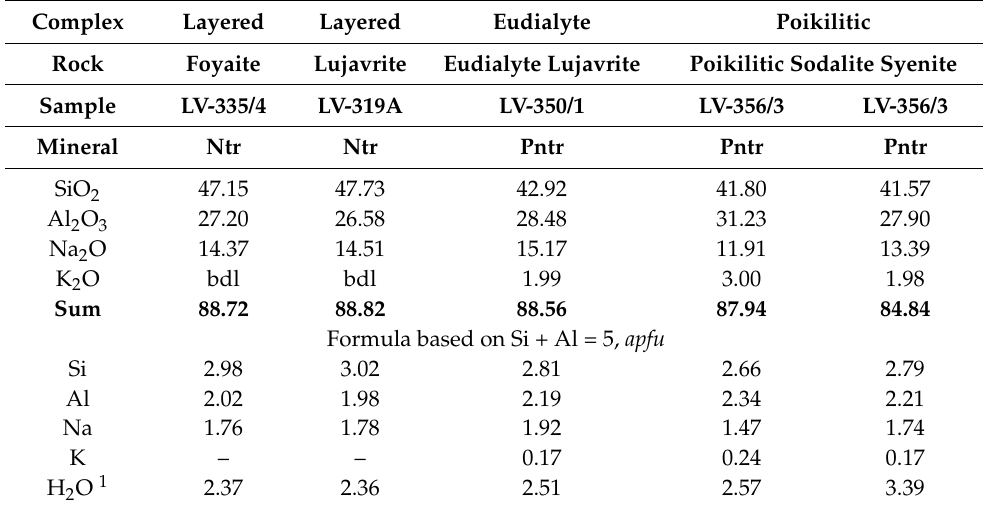
Table 6. Representative chemical analyses of natrolite and paranatrolite from Lovozero rocks (micro- probe, wt.%). Complex Layered Layered Eudialyte Poikilitic Rock Foyaite Lujavrite Eudialyte Lujavrite Poikilitic Sodalite Syenite Sample LV-335/4 LV-319A LV-350/1 LV-356/3 LV-356/3 Mineral Ntr